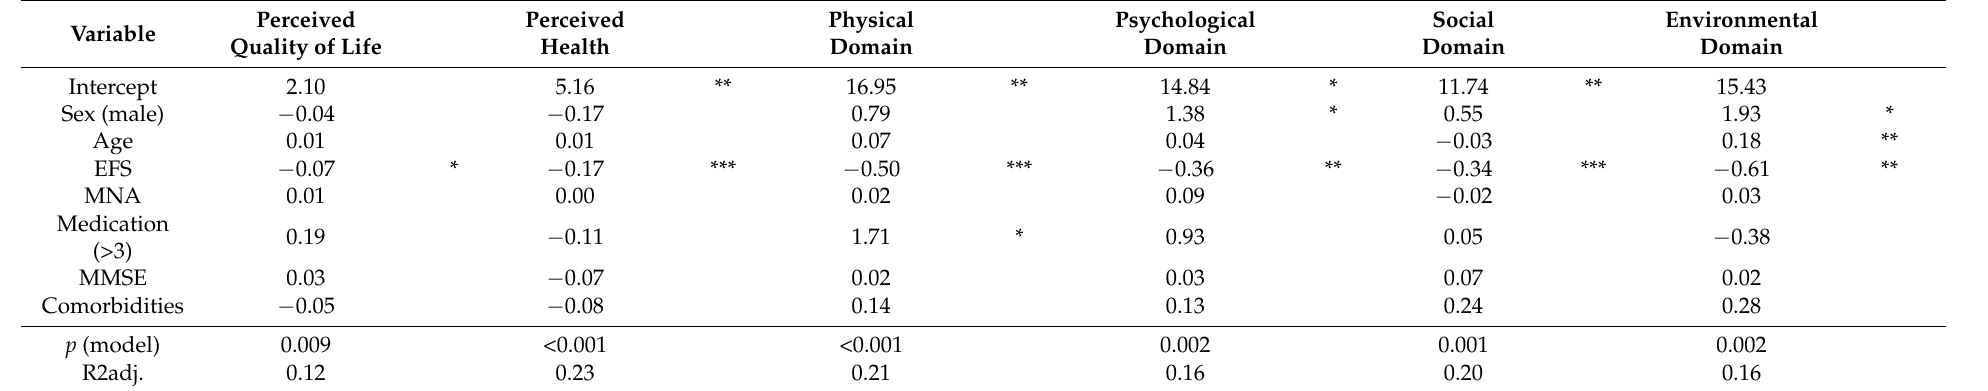
Table 6. Multiple linear regression model (coefficients are given) for the impact of selected variables on WHOQoL-BREF domain scores.